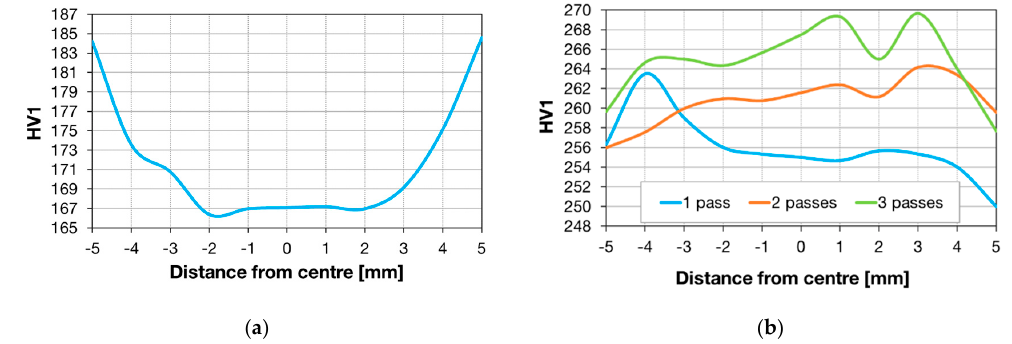
Figure 13. Hardness measurement: ( a ) HV1 hardness profile, as-received condition; ( b ) HV1 hardness profiles vs. number of passes through Conform SPD.